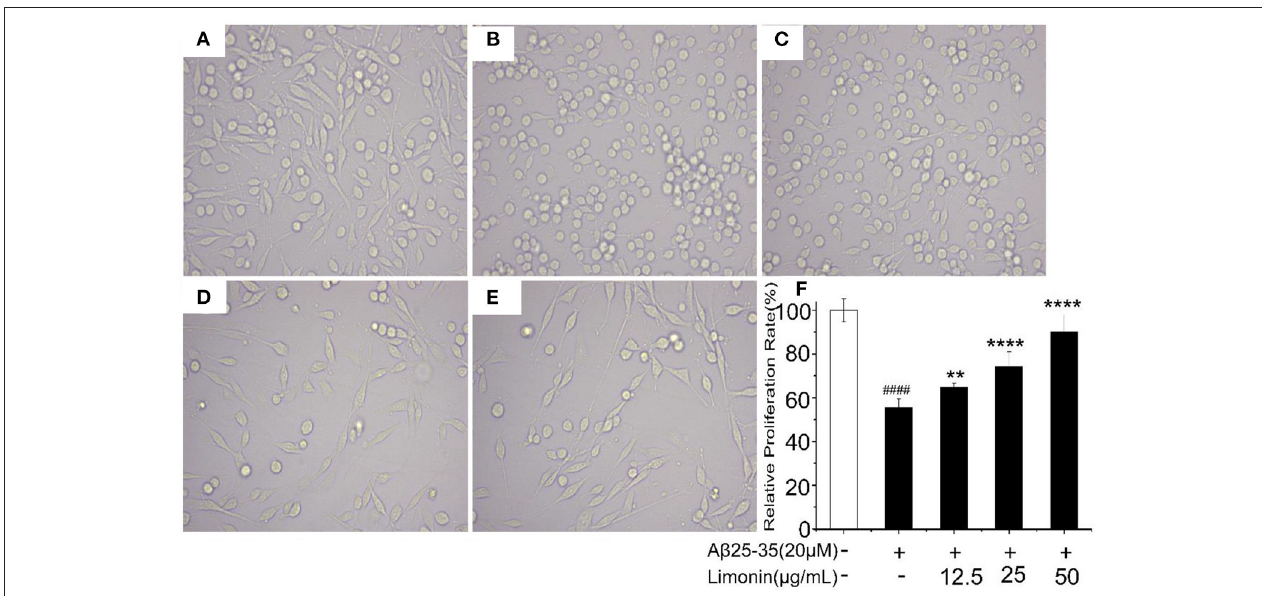
FIGURE 2 | Morphological changes of PC12 cells with different treatments. (A) Control group; (B) A β 25 − 35 group; (C) A β 25 − 35 + 12.5 µ g/mL limonin group; (D) A β